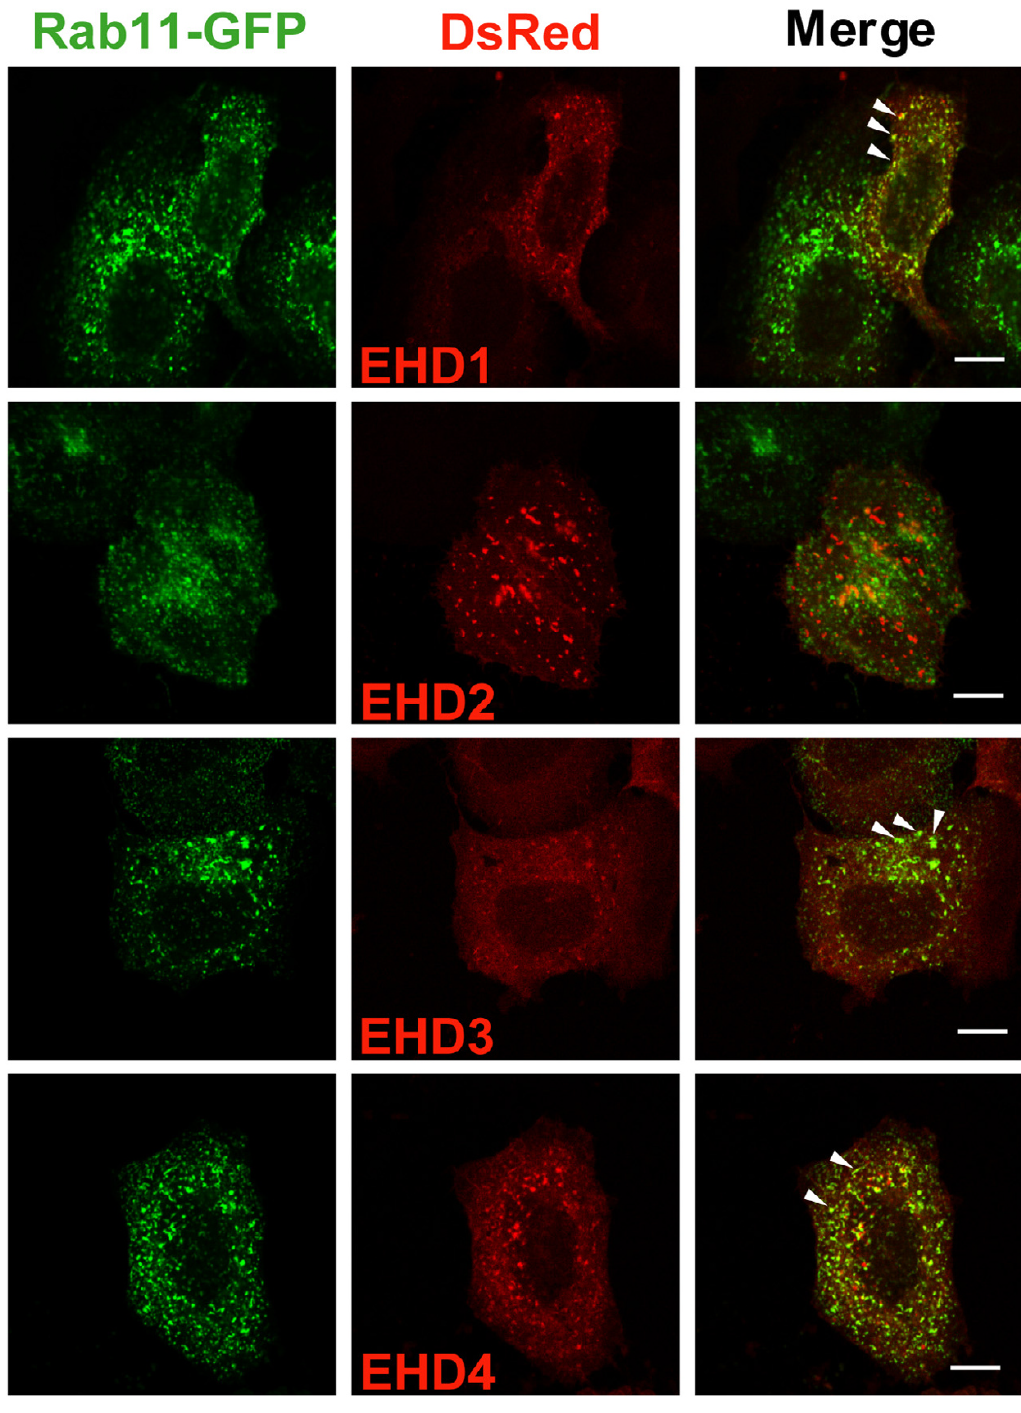
Figure 7 Colocalization of EHD proteins with the endocytic recycling marker Rab11 . HeLa cells were co-transfected with Rab11-GFP (green) and EHD-DsRed (red) proteins for 24 h, fixed, mounted and scanned by a confocal microscope equipped with a 100× objective lens. Colocalization is indicated when similar shaped structures appear yellow in the Merge (arrow- heads). Bar, 10 µ